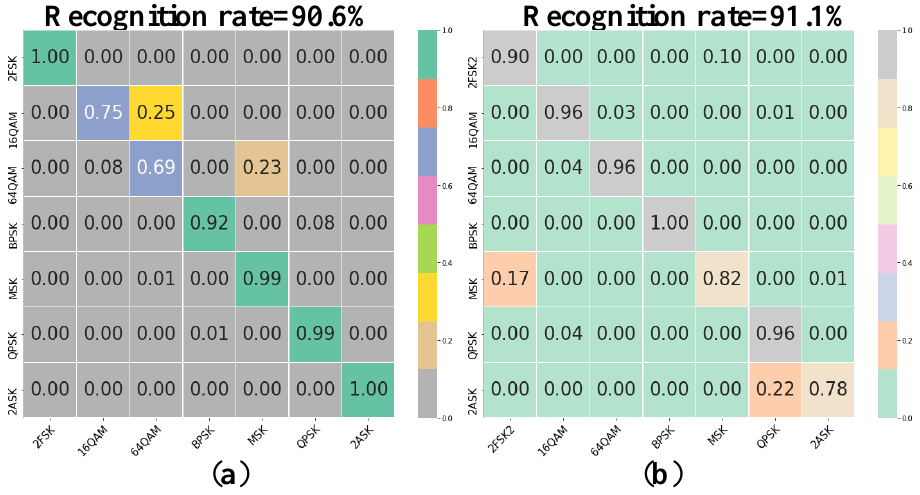
Figure 9. Multidimensional hybrid network confusion matrices. ( a ) This is the training result of da- taset 1 in which the signal parameters to be recognized are consistent with those of the training set. ( b ) This is the training result of dataset 2 in which the signal parameters to be recognized are incon- sistent with those of the training set.